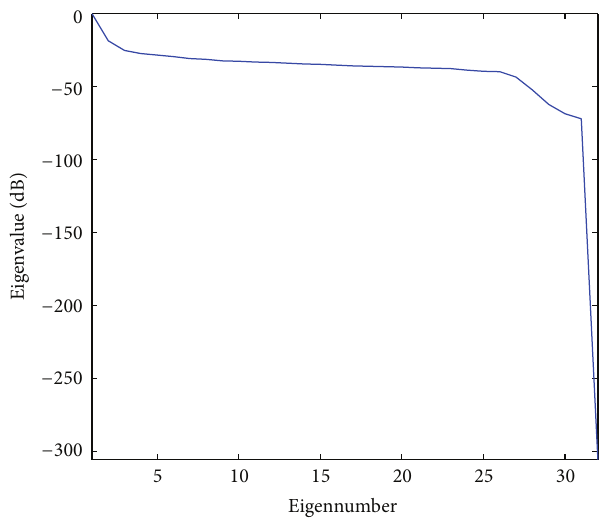
Figure 7: Eigenspectrum of the correlation function of signals at the reserved range bins.